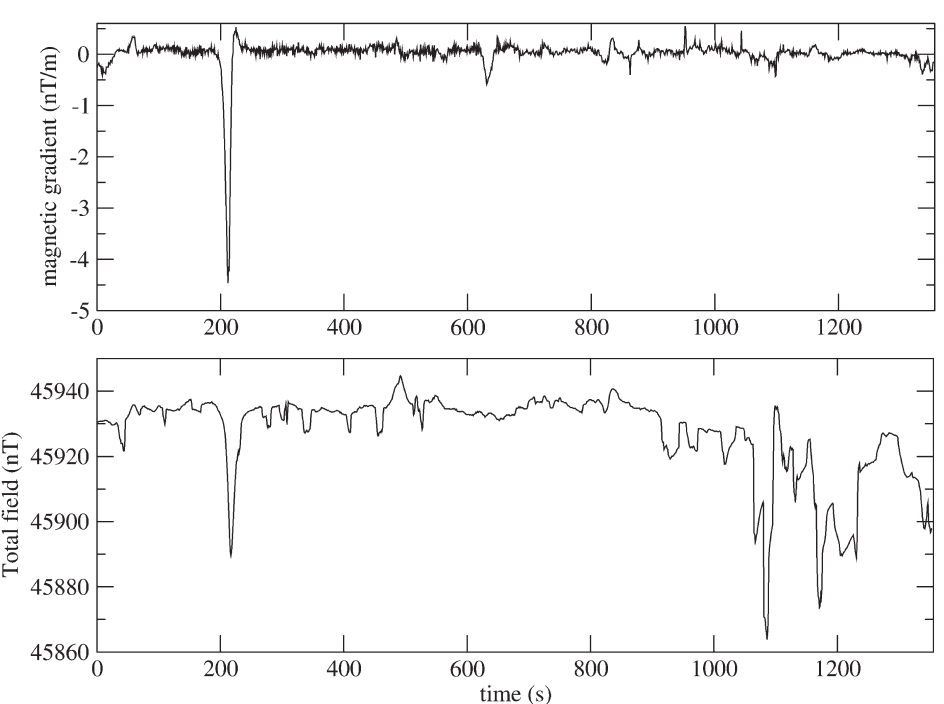
Fig. 5. Example of the magnetic signal (bottom panel) and gradient signal (upper panel) along a survey line. The large anomaly on the left is due to some magnetic sources, while the anomalies on the right, which are pres- ent only on the magnetic signal and not in the gradient, are probably due to anthropic noise.